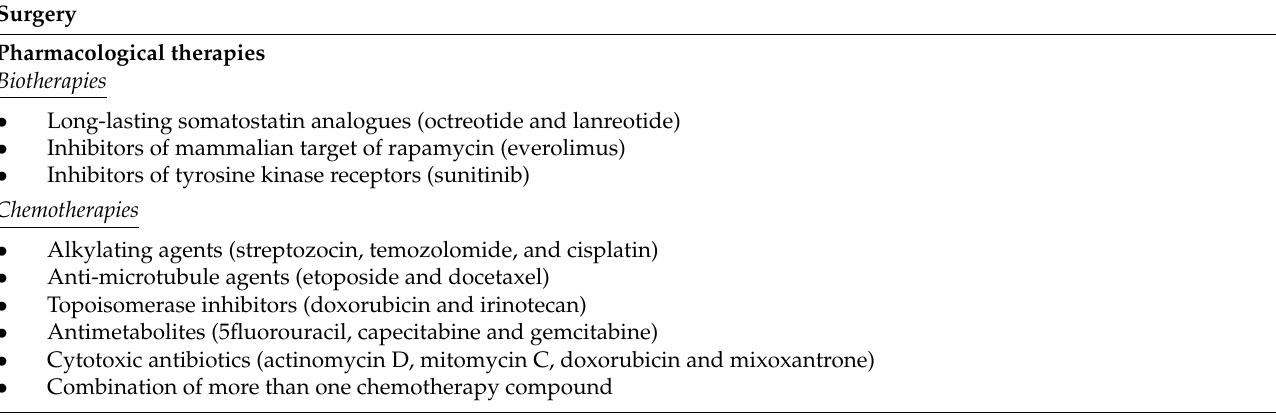
Table 2. Main treatments currently employed for MEN1